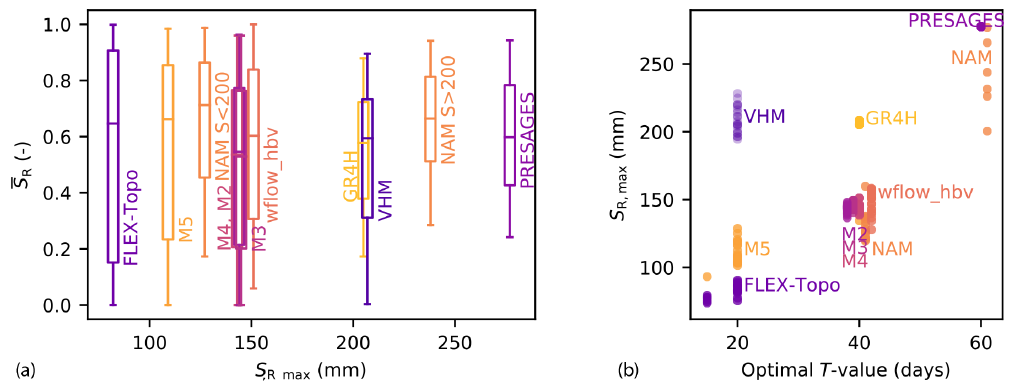
Figure 6. (a) Range of relative root-zone soil moisture S R in the Ourthe upstream of Tabreux for the period 2015–2017 as a function of the median root-zone storage capacity ( S R , max ) across parameter sets. The feasible parameters for NAM are split into two groups due to the large variability of S R , max (subsets with S R , max of ∼ 130 and ∼ 240mm). (b) Root-zone storage capacity S R , max as a function of the optimal T value for each model realization. Optimal T values are derived at the highest Spearman rank correlation between the Soil Water Index and modeled root-zone soil